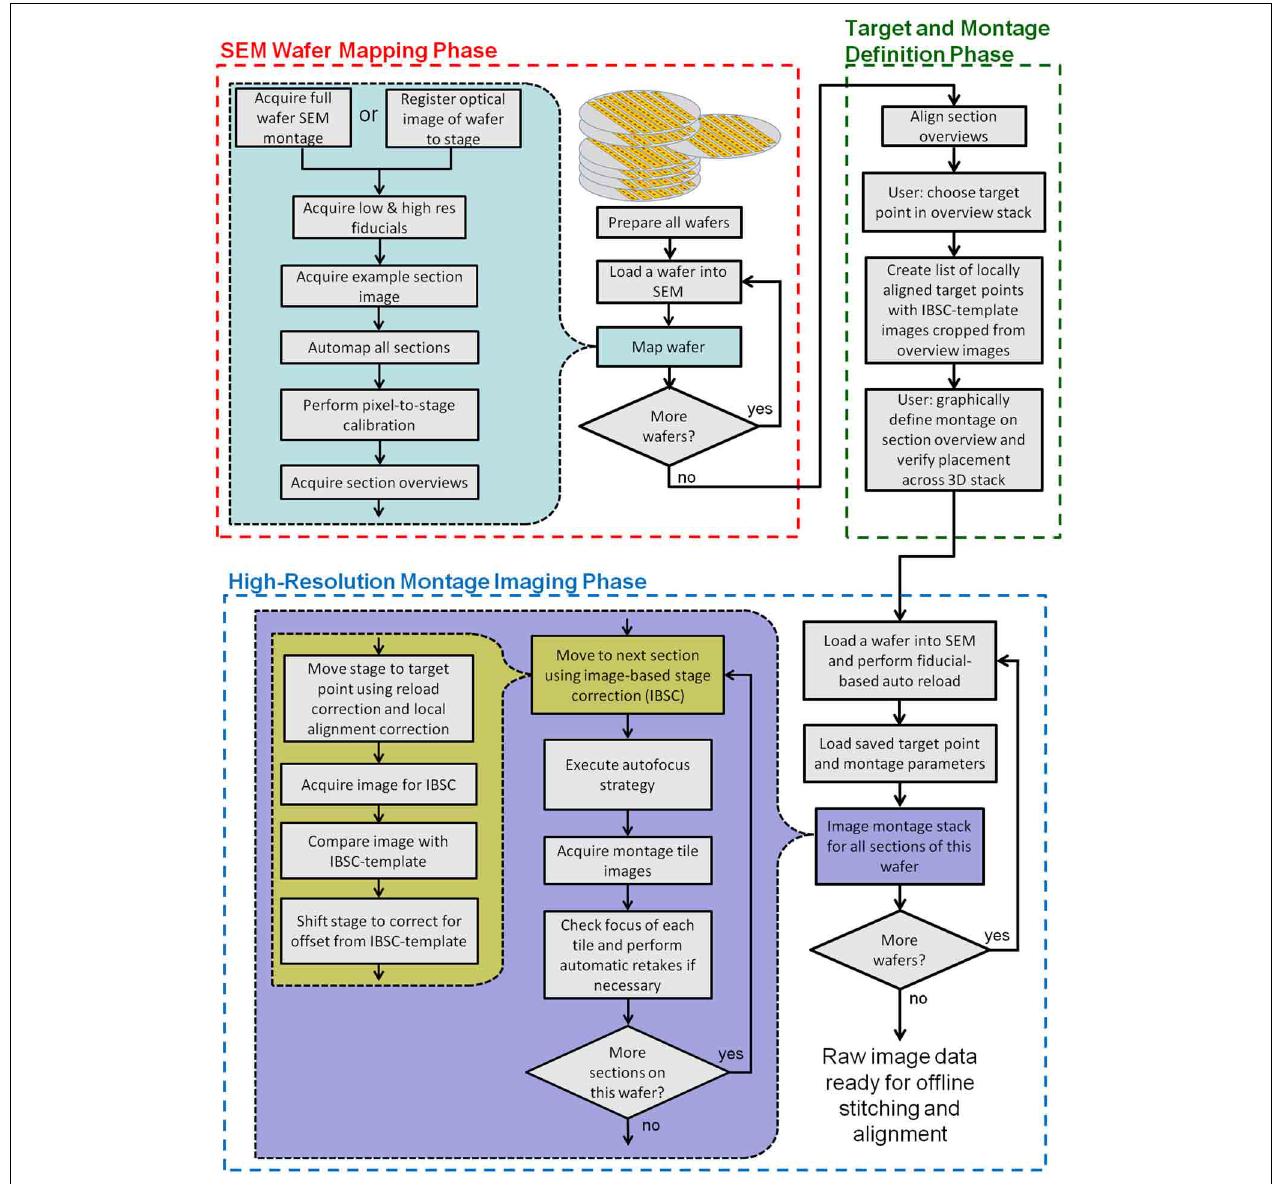
FIGURE 3 | Flow chart showing all key steps in the creation and imaging of a UTSL using WaferMapper. The process is broken into three phases: an “SEM Wafer Mapping Phase,” a “Target and Montage